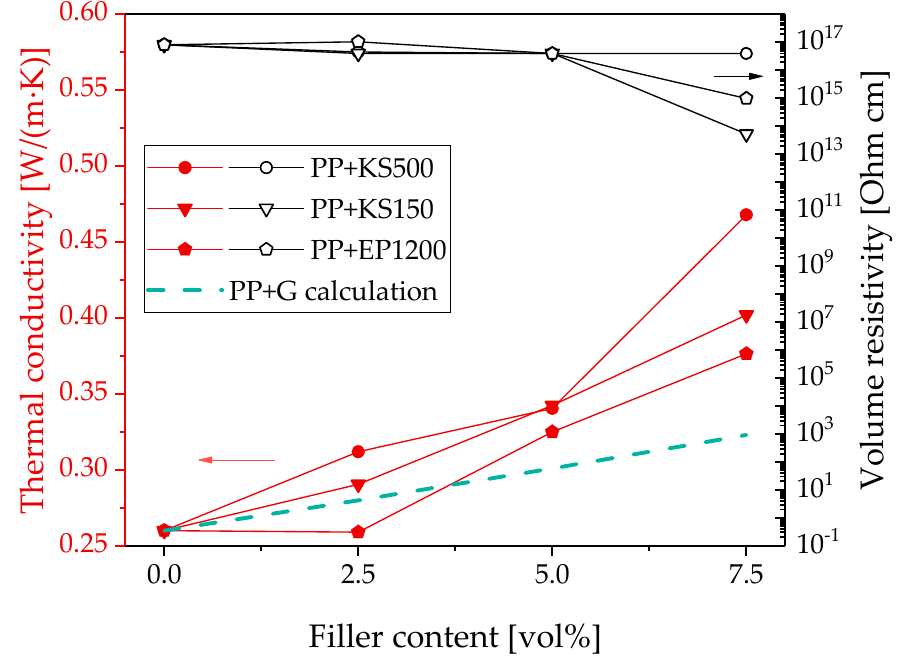
Figure 2. Thermal conductivity and electrical volume resistivity of PP filled with di ff erent kinds of graphite; values calculated using the Hatta model [48].